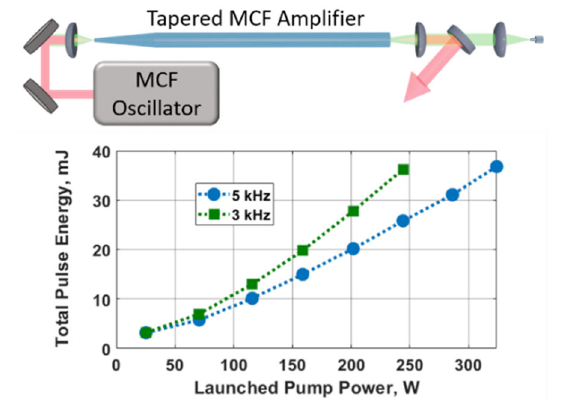
Fig. 2. (Top) schematic of MCF energy extraction experiment. (Bottom) extracted pulse energies at 3 kHz and 5 kHz repetition rate.